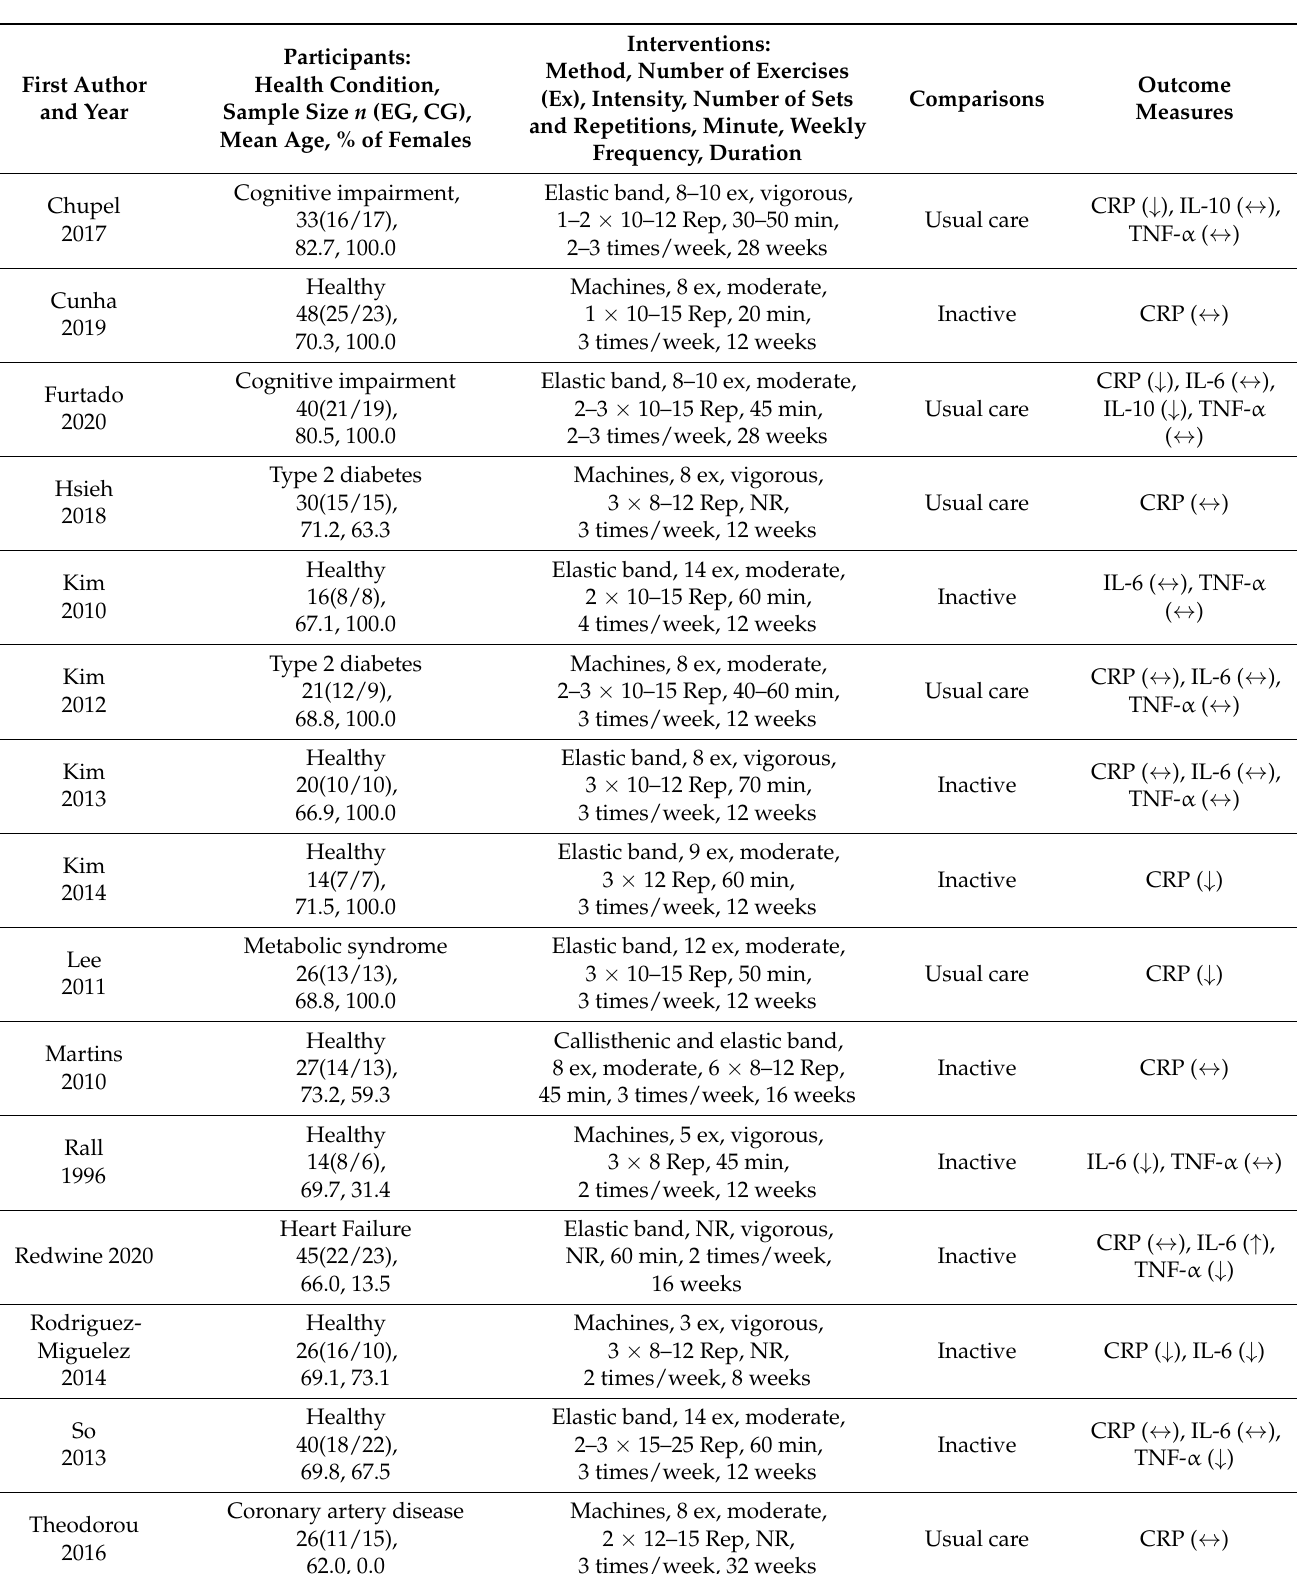
Table 1. Characteristics of included